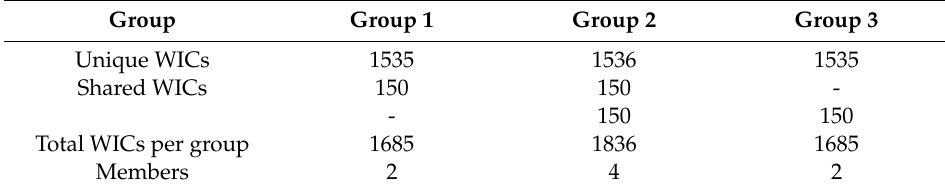
Table 8. Annotation